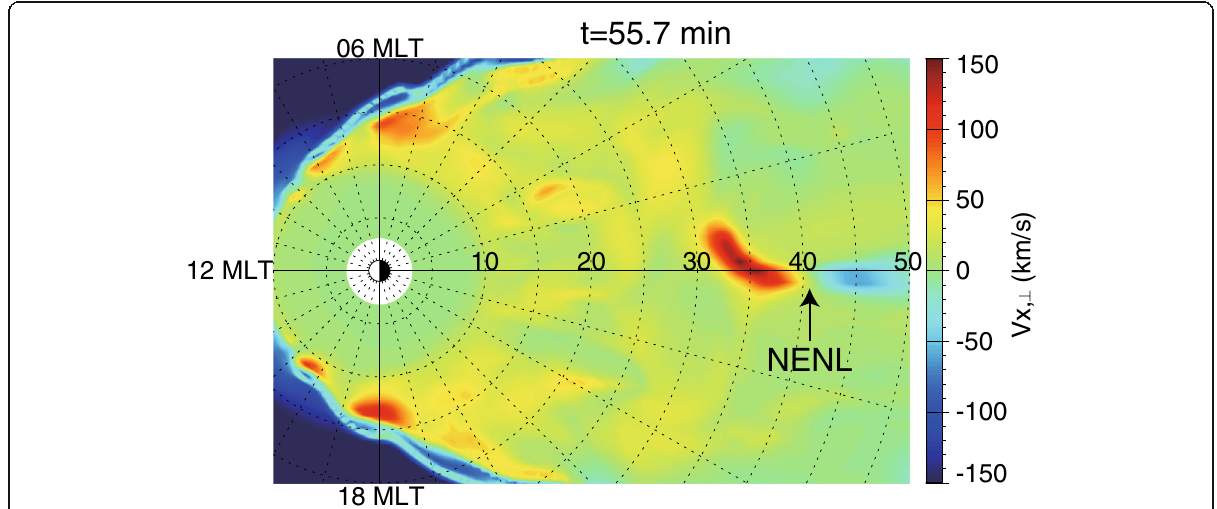
Fig. 9 X -component of the perpendicular plasma flow velocity in the equatorial plane at T = 55.7 min